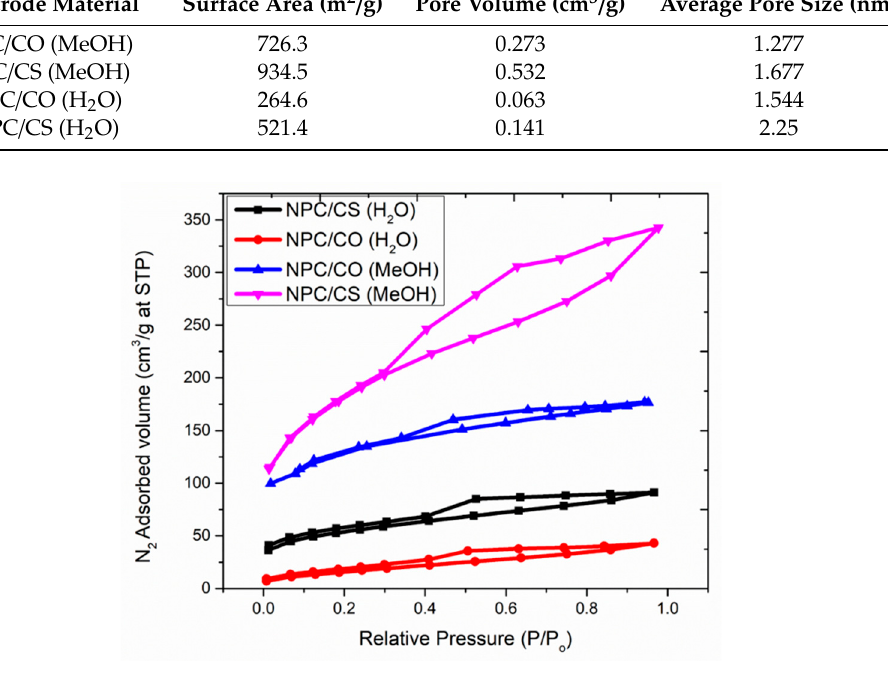
Figure 5. N 2 adsorption isotherms at 77K. Table 2. Surface area, pore volume, and average pore size of NPC/CO and NPC/CS.